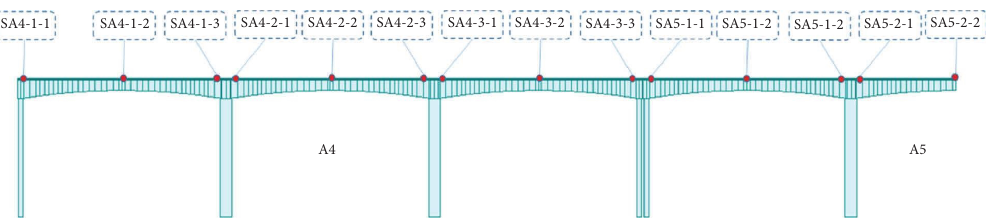
Figure 7: Beam element stress statistical point.